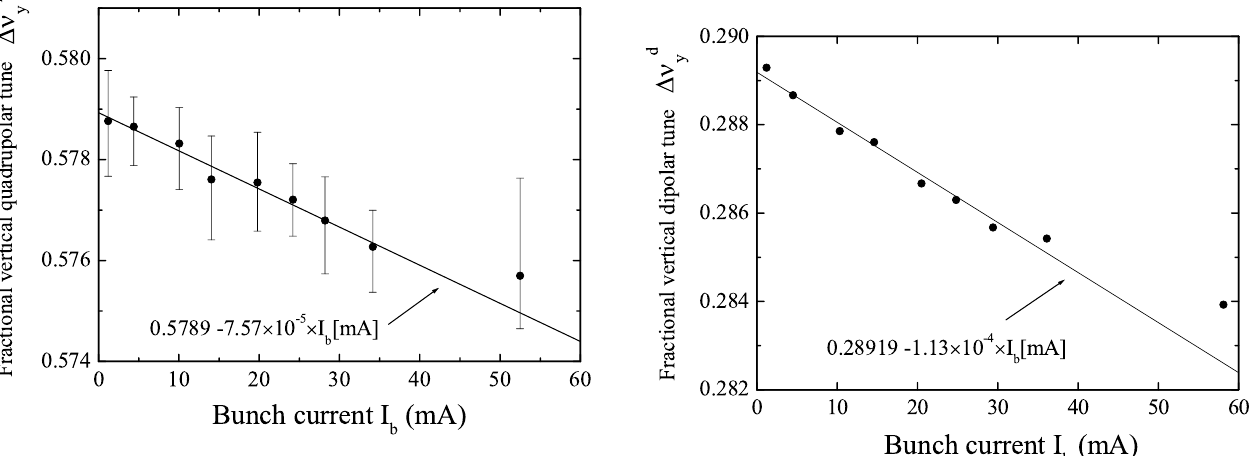
FIG. 9. Measured fractional vertical tunes of the dipolar oscil- lations as a function of the beam current per bunch under single- bunch operation.